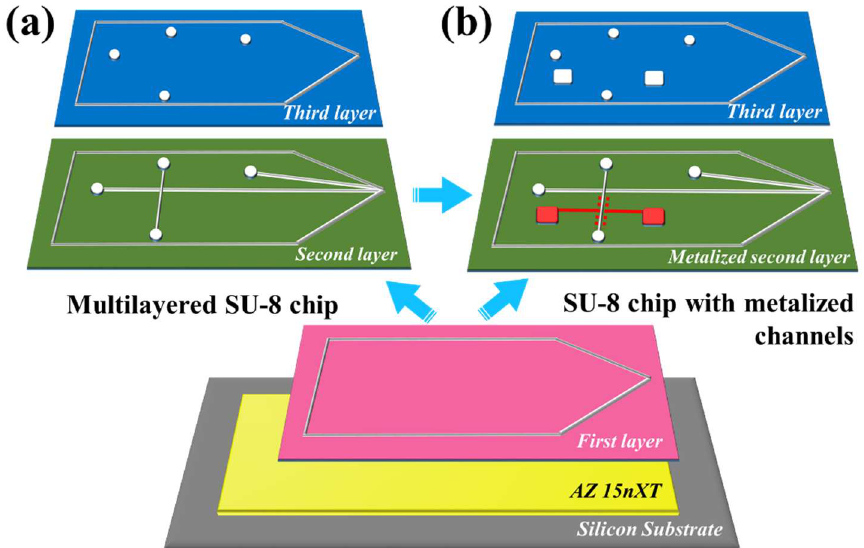
Figure 1. Schematics of multilayer SU-8 free-standing microfluidic device for mass spectroscopy electro spray ionization. ( a ) the multilayered SU-8 ESI chip ( b ) SU-8 chip with extra metallization step.